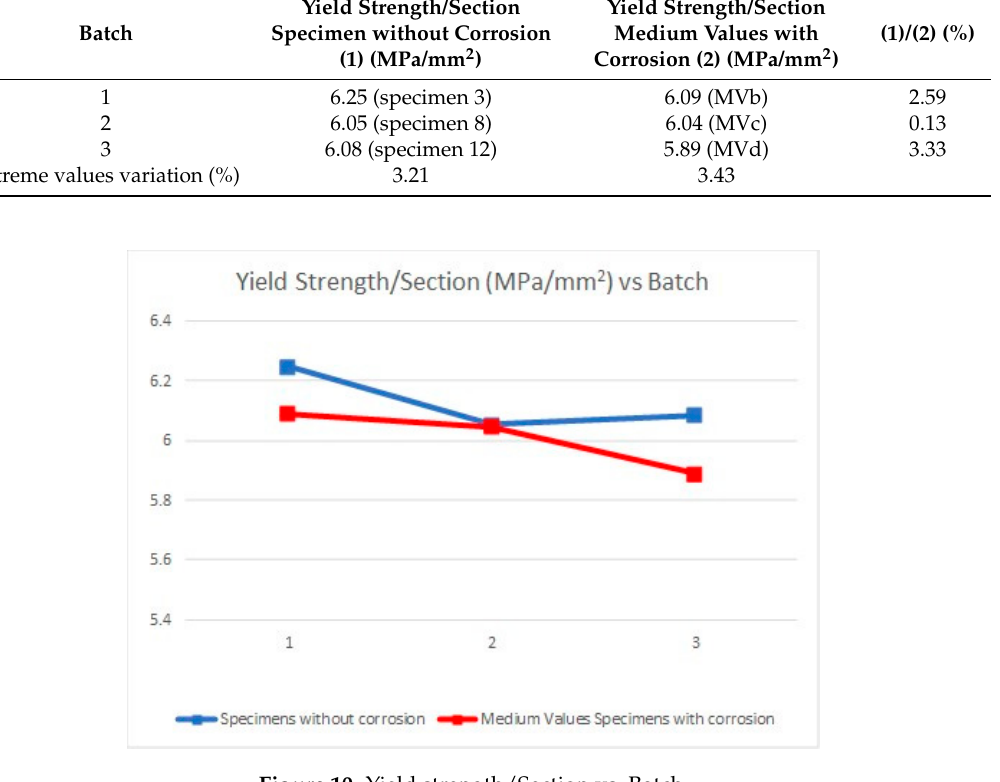
Figure 10. Yield strength/Section vs. Batch. Table 9. Tensile strength/Section values per specimen and Medium values vs. Batch.